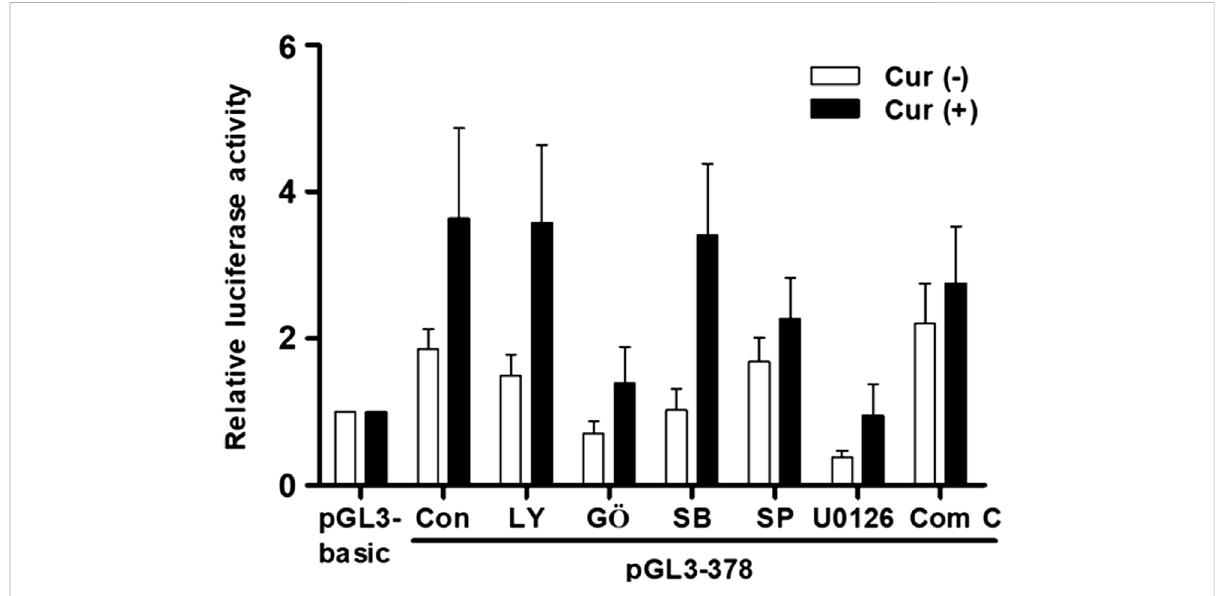
FIGURE 6 EffectofcurcuminonsignalingpathwaycontrollingtranscriptionofhST6GalNAcIinHCT116cells.ThepGL3-378(positivecontrol),pGL3-basic (negative control) and pRL-TK (internal control) were co-transfected into HCT116 cells. Transfected cells were incubated in the presence (solid bar) andabsence(openbar)of50 μ McurcuminwithLY294002(10 μ M),U0126(10 μ M),SP600125(10 μ M),G Ő 6983(100 nM),andCompoundC(10 μ M) inhibitors for 24 h. Relative luciferase activity was normalized with the Renilla luciferase activity derived from pRL-TK. Data represent mean ± SEM for three independent experiments with triplicate